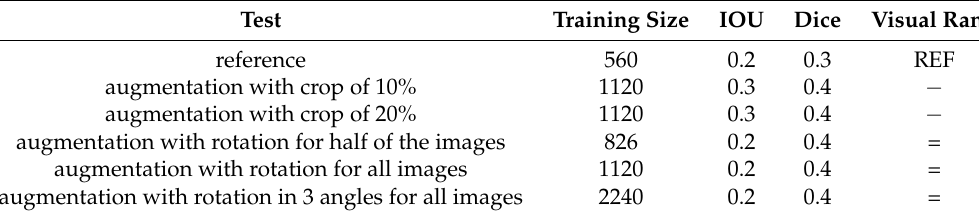
Table 4. Effect of the augmentation of fixed-scale tiles on segmentation results. Test Training Size IOU Dice Visual Rank reference augmentation with crop of 10% augmentation with crop of 20% augmentation with rotation for half of the images 826 augmentation with rotation for all images augmentation with rotation in 3 angles for all